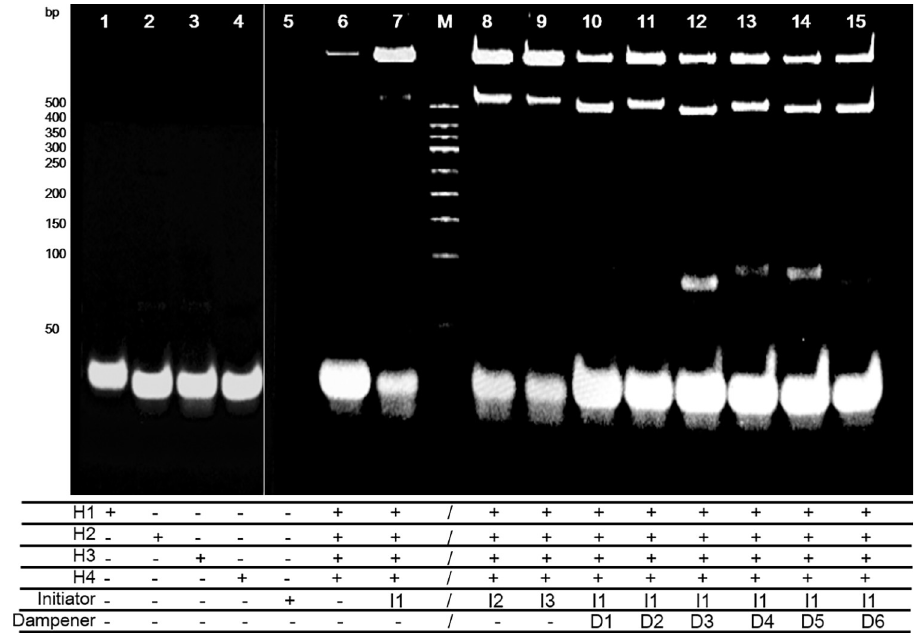
Fig 3. Polyacrylamide gel for the HCR